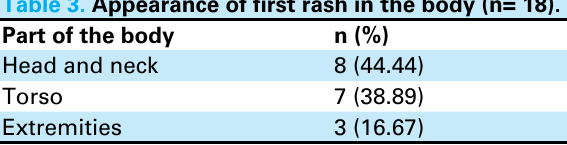
Table 3. Appearance of first rash in the body (n=